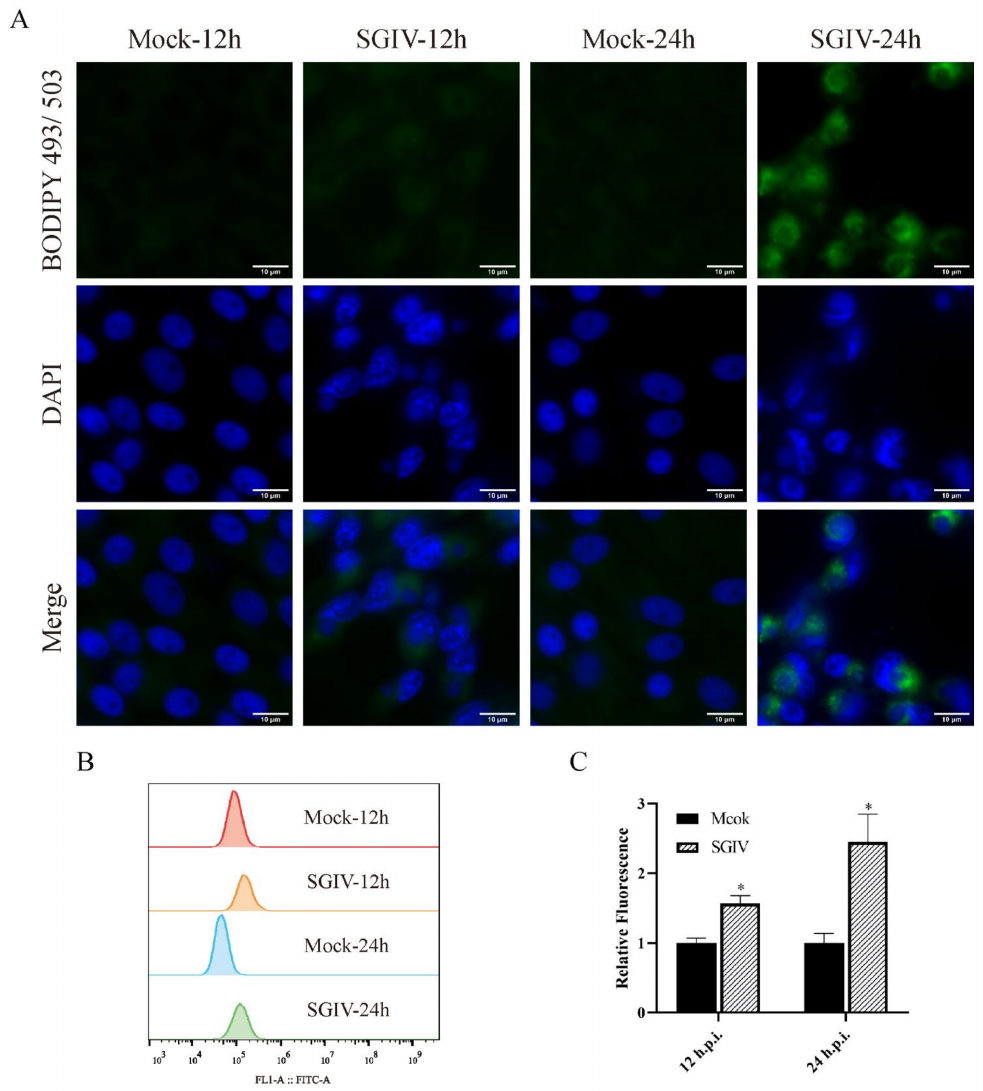
Figure 2. SGIV infection induced the formation of lipid droplets. The lipid droplets in SGIV-infected cells were stained with BODIPY ® 493/503. Mock or SGIV-infected cells were stained with BODIPY ® 493/503 for 15 min and then observed under fluorescence microscopy ( A ). The quantity of LDs was measured by flow cytometry, and the 4 curves indicate the fluorescence intensity ( B , C ). n = 3, data are expressed as means ± SD, * indicates p <